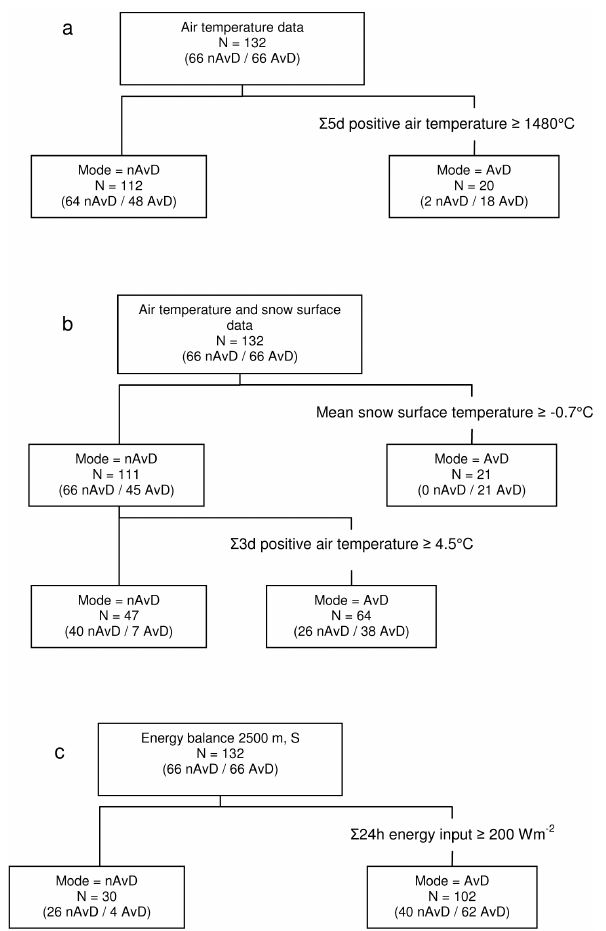
Fig. 5. (a) Classification tree for WFJ using air temperature infor- mation, (b) classification tree for air temperature and snow surface information and (c) for a virtual south-facing slope with energy bal- ance information only (for predictive skills see Fig. 6).